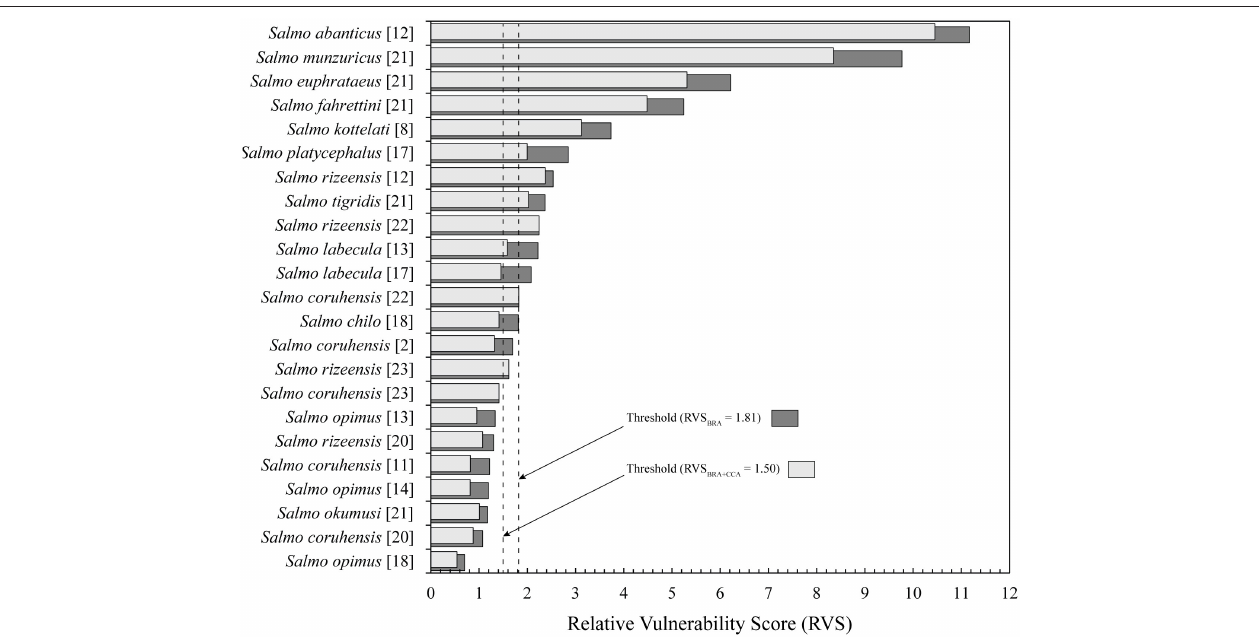
FIGURE 5 | Relative Vulnerability Scores (RVS) of native Salmo species and populations in Turkey. Brackets ([ ]) after species (or populations) present river basin codes are as per Figure 2